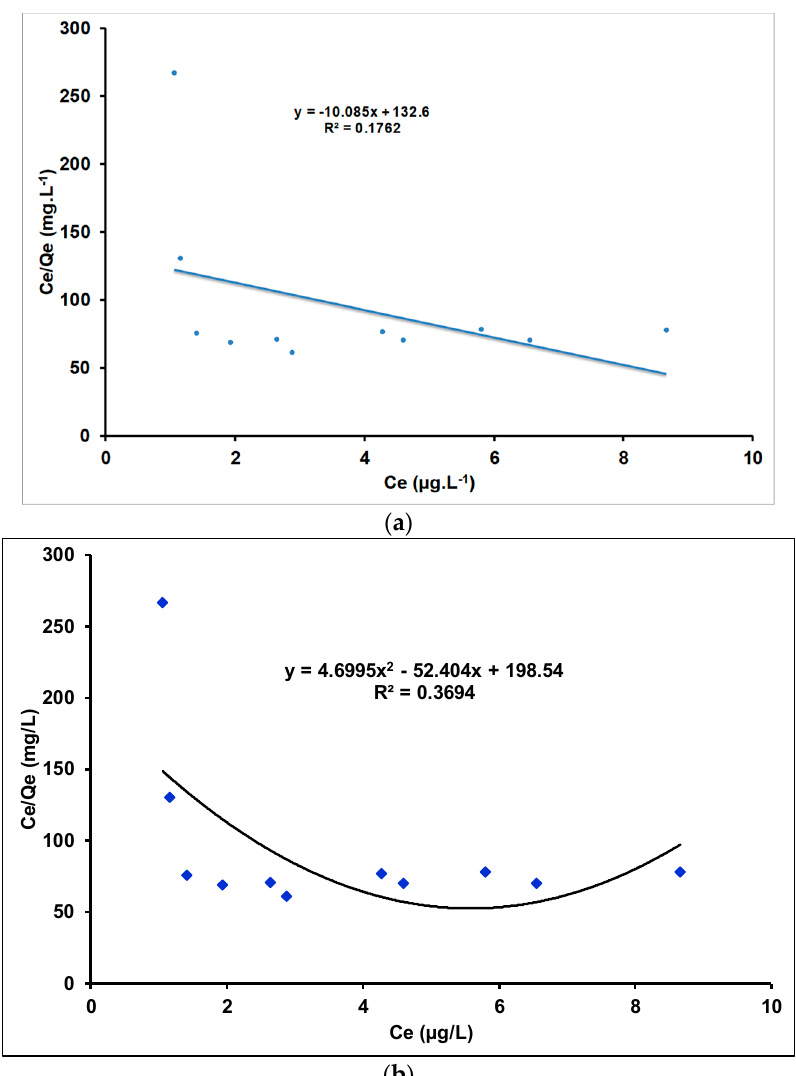
Figure 14. Langmuir isotherm of Tl(I) adsorption on γ ANPs: ( a ) linear model and ( b ) quadratic model.